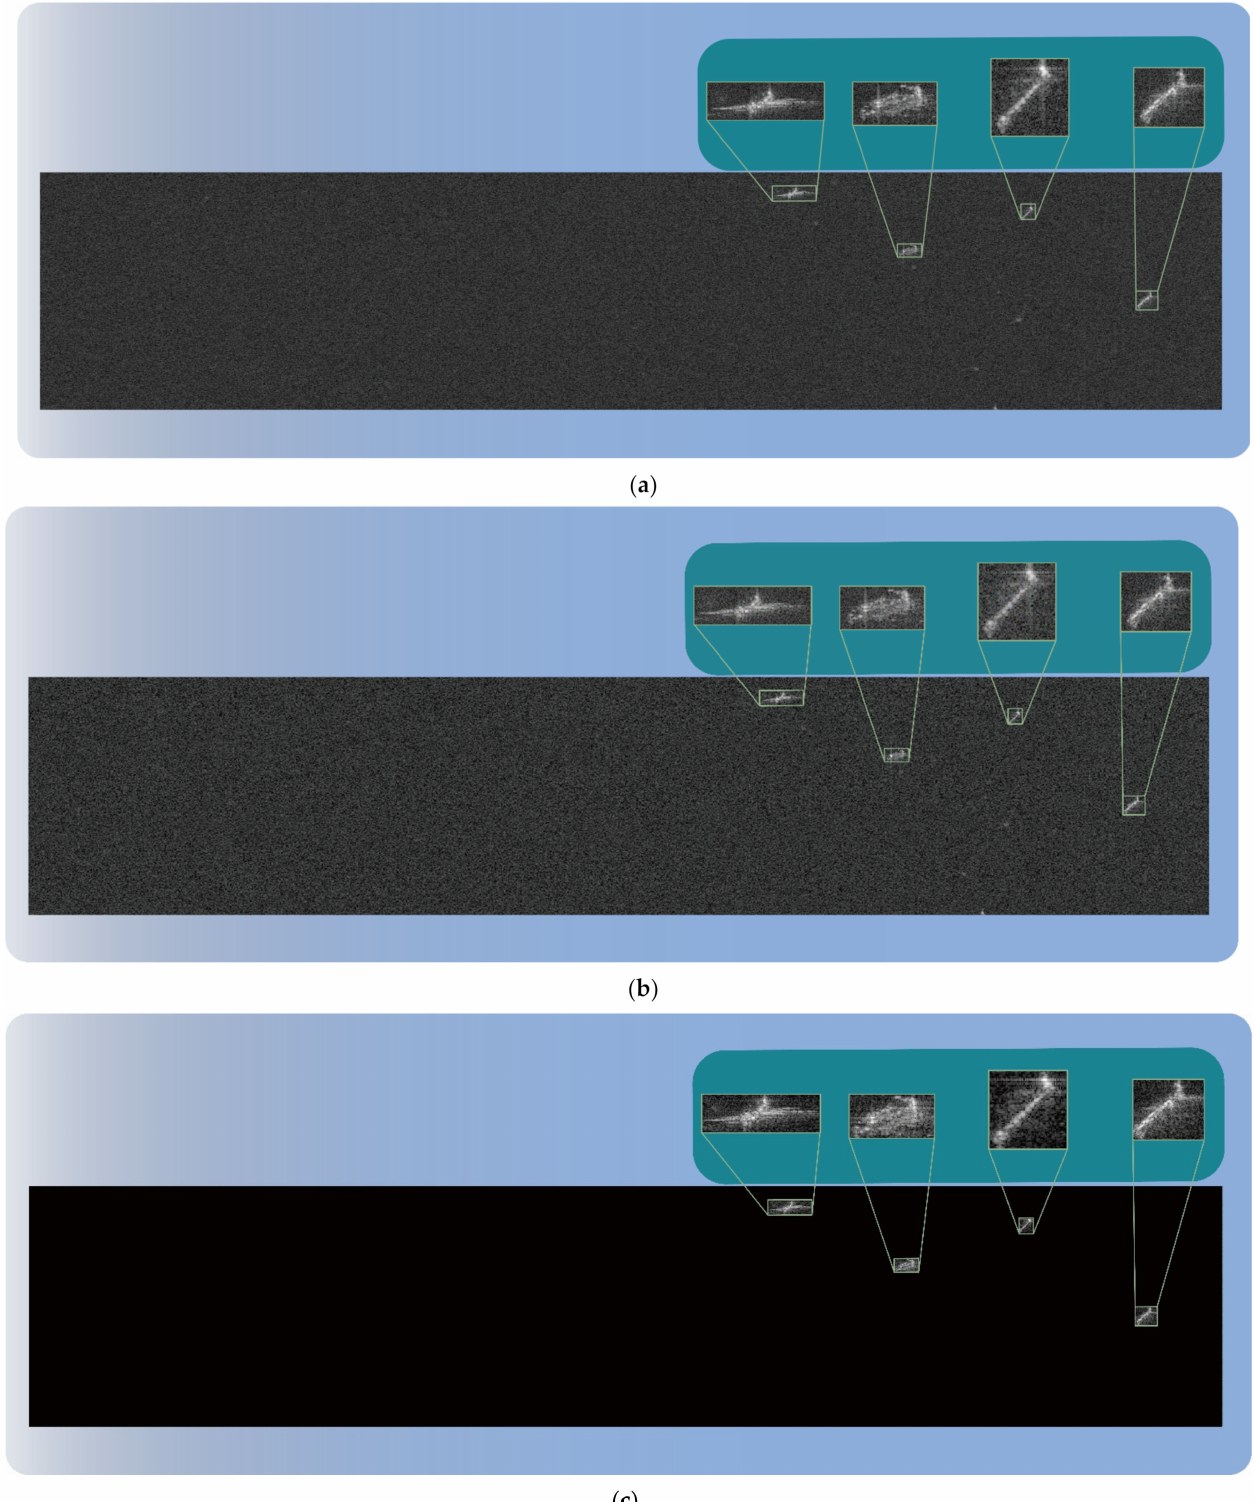
Figure 16. Imaging results of the typical extended scene. ( a ) Result of the current framework; ( b ) result of the framework with CFBP; ( c ) result of the proposed